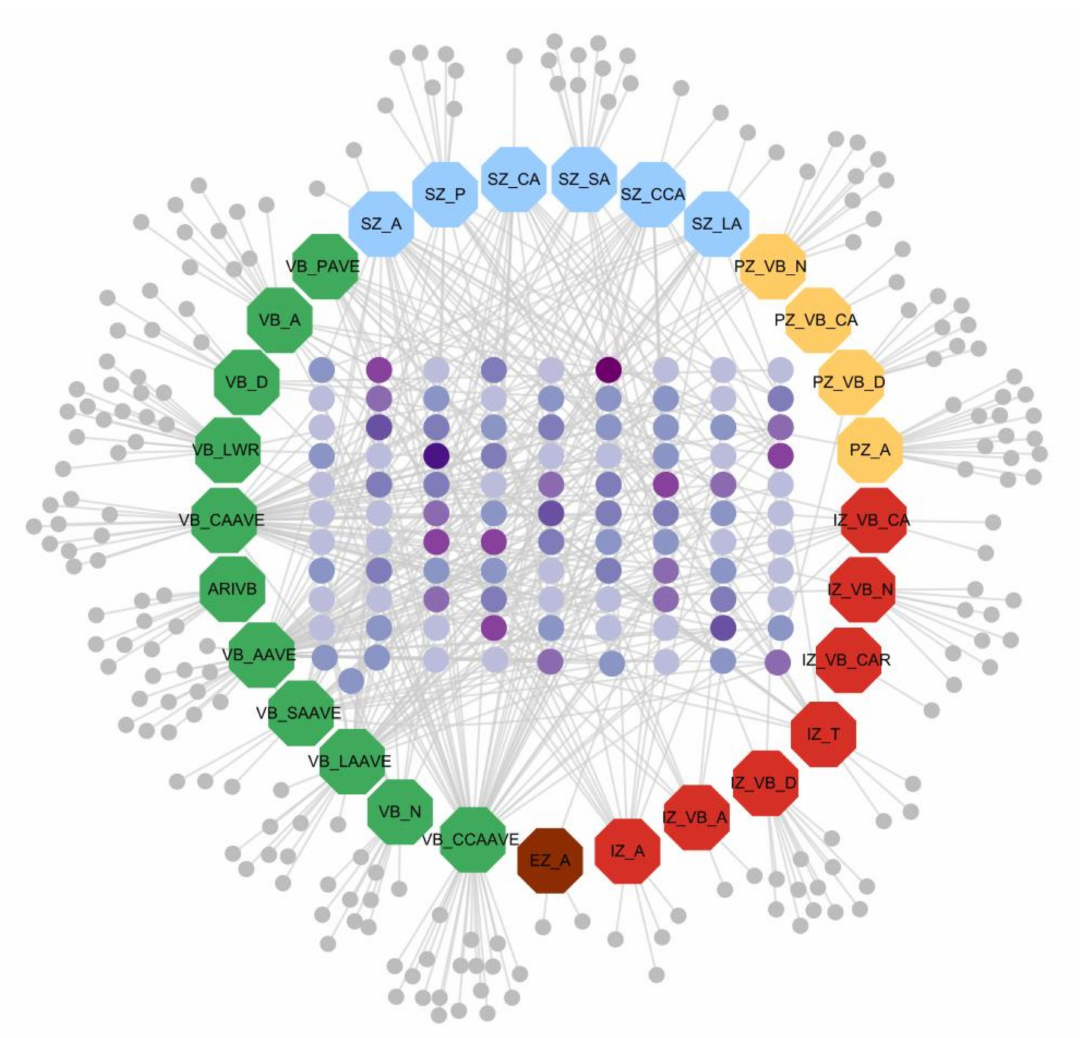
Figure 5. The gene-phenotypic trait network constructed by 30 phenotypic traits and their related genes. For the 29 large octagon nodes, the 11 green nodes represent vascular-bundle-related traits (VB_SAave, VB_Pave, VB_N, VB_LWR, VB_LAave, VB_D, VB_CCAave, VB_CAave, VB_Aave, VB_A, and ARIVB), the 6 blue nodes represent cross-section-related traits (SZ_SA, SZ_P, SZ_LA, SZ_CCA, SZ_CA, and SZ_A), the 4 yellow nodes represent periphery zone-related traits(PZ_VB_N, PZ_VB_CA, PZ_VB_D, and PZ_A), the 7 red nodes represent inner zone-related traits (IZ_VB_N, IZ_VB_D, IZ_VB_CAR, IZ_VB_CA, IZ_VB_A, IZ_T, and IZ_A), and the 1 brown node represents an epidermis- zone-related trait (EZ_A). Genes are represented by the small round nodes, and different colours indicate different attributes. The purple round nodes represent the overlapped genes of multiple traits, and there were 100 overlapped genes (purple round nodes represent the overlapped genes of 11 traits, indigo round nodes represent the overlapped genes of 8 traits, dark violet round nodes represent the overlapped genes of 7 traits, dark orchid round nodes represent the overlapped genes of 6 traits, blue violet round nodes represent the overlapped genes of 5 traits, medium orchid round nodes represent the overlapped genes of 4 traits, medium slate blue round nodes represent the overlapped genes of 3 traits, and medium purple round nodes represent the overlapped genes of 2 traits). The darker the colour, the more traits are associated; the light grey round nodes stand for genes only have correlation with specific